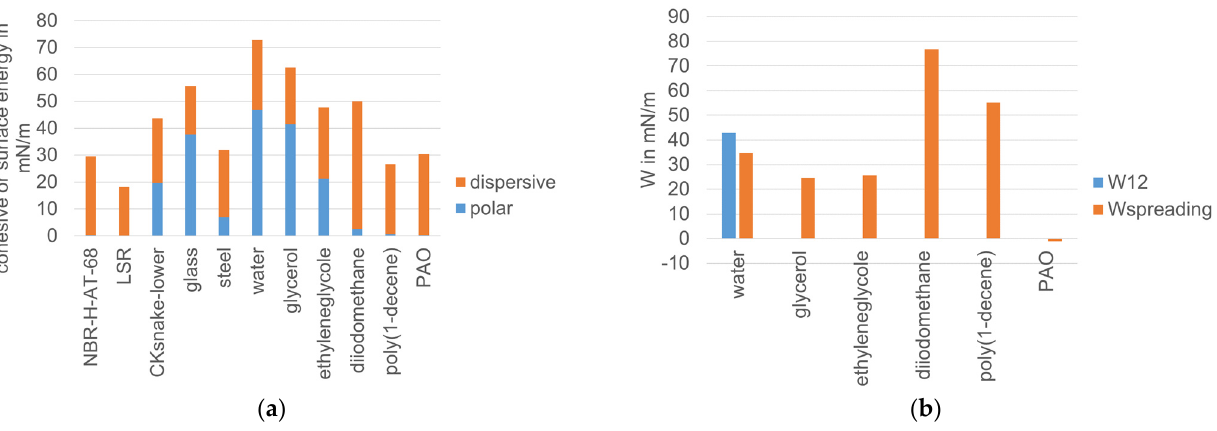
Figure 8. Energetic situation: ( a ) Surface energies of LSR compared to other materials and cohesive energies of liquids, ( b ) adhesive energy W 12 of solid partners (dry contact) and W spreading energy of the lubricated systems for an LSR50–steel contact (lubricated contact).